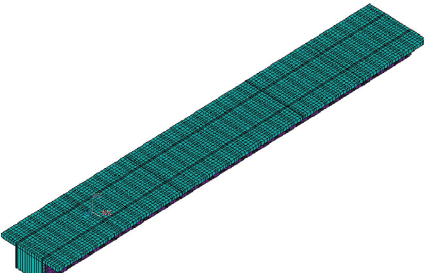
Figure 11: Finite element model of the single box and single cell composite box girder with 625